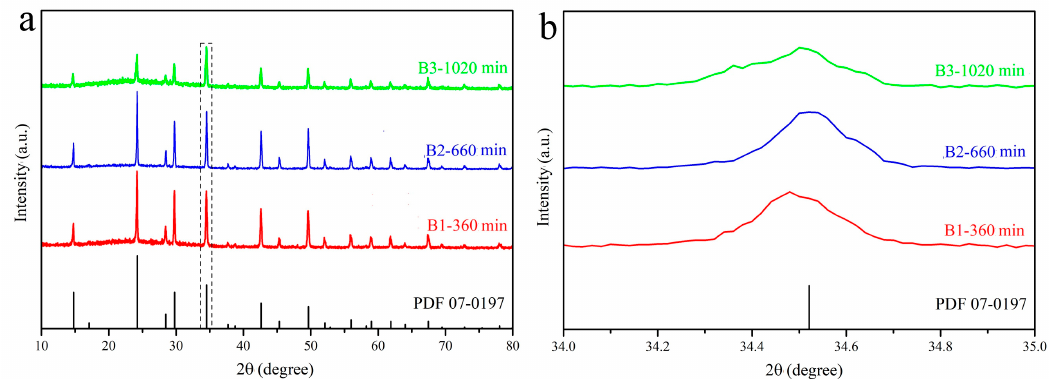
Figure 3. ( a ) The XRD patterns of Ce doped Cs 2 SnCl 6 prepared at di ff erent reaction time; ( b ) the zoom Figure 3. (a) The XRD patterns of Ce doped Cs 2 SnCl 6 prepared at different reaction time; ( b ) the in view in the range of 34–35 ◦ . zoom in view in the range of 34-35 o .